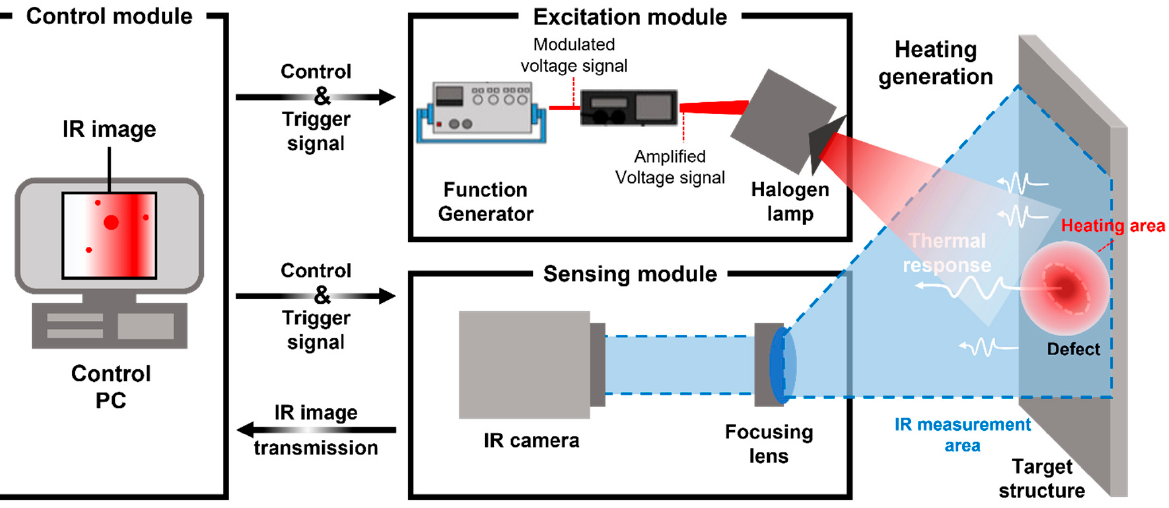
Figure 5. PP-GF20 plate as a test sample with artificial defects: ( a ) group 1, ( b ) group 2, ( c ) group 3, ( d ) group 4.